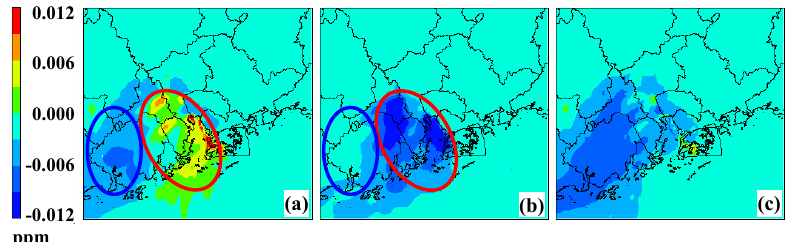
Fig. 14. Surface O 3 change averaged over 12:00–17:00LST on 16–22 October 2004 due to a 25% reduction in anthropogenic emissions of (a) NO x only, (b) VOCs only, and (c) both NO x and VOCs. The blue and red ellipses mark the regions with the O 3 change characterized by NO x -limited chemistry and by VOC-limited chemistry, respectively.